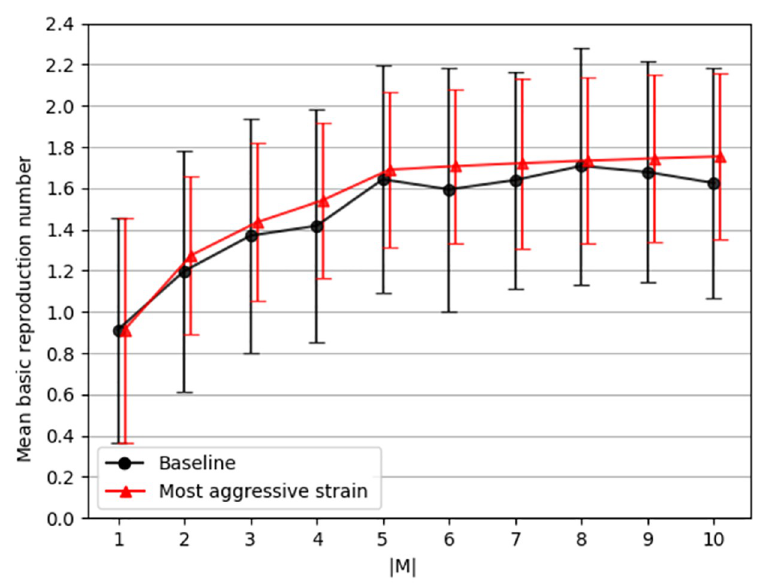
Fig 2. The mean base reproduction number ( E [ R 0 ( t )]) as a function of the number of strains (| M |). The black (with circle markers) line indicates the baseline dynamics of the simulation where each strain has unique parameter values. On the other hand, the red (with triangle markers) line indicates the case where all the strain parameters values have been replaced with one of the most aggressive strains. The results are mean ± standard division for n = 1000 repetitions.